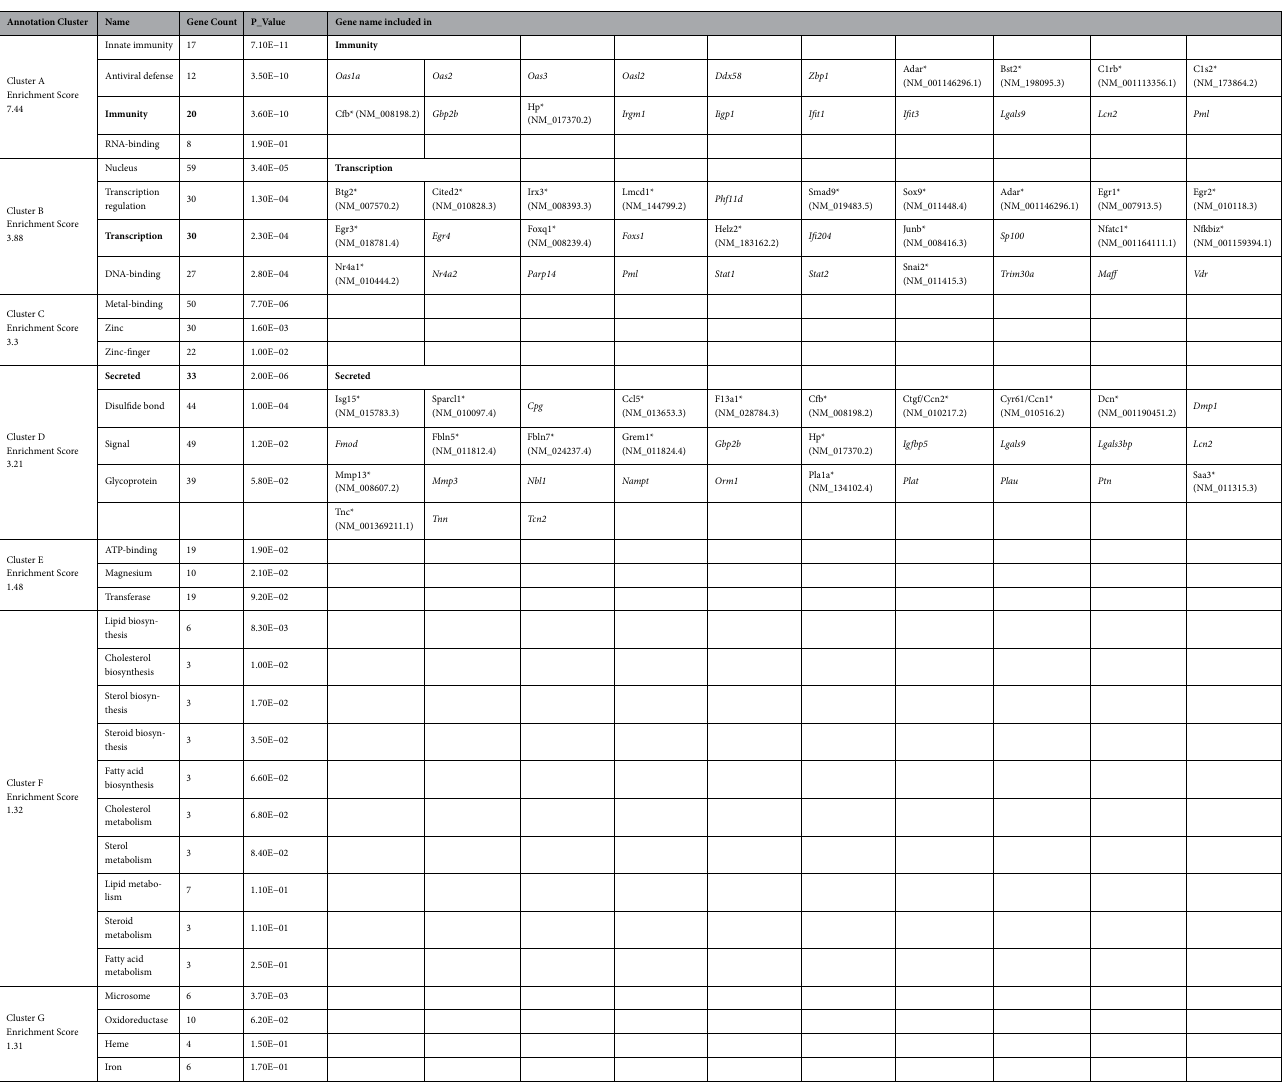
Table 1. List of enriched annotation clusters of the 179 LIPUS-responsive